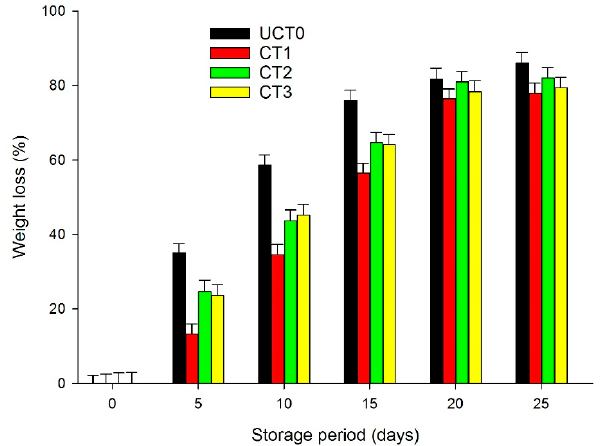
Figure 1. Weight loss (%) of Golden Delicious apple slices coated (with CT1, CT2, and CT3), and not treated (UCT0) at day 0, and after 5, 10, 15, 20, and 25-days of storage at 4 °C in dark conditions and 85% relative humidity (RH). Values are means ± standard deviations ( n = 3). Abbreviations: UCT0, uncoated apple slices used as control; CT1, apple slices coated with chitosan-glycerol-cinnamon oil; CT2, apple slices coated with guar gum-glycerol-cinnamon oil; CT3, apple slices coated with composite guar gum-starch-glycerol-cinnamon oil.